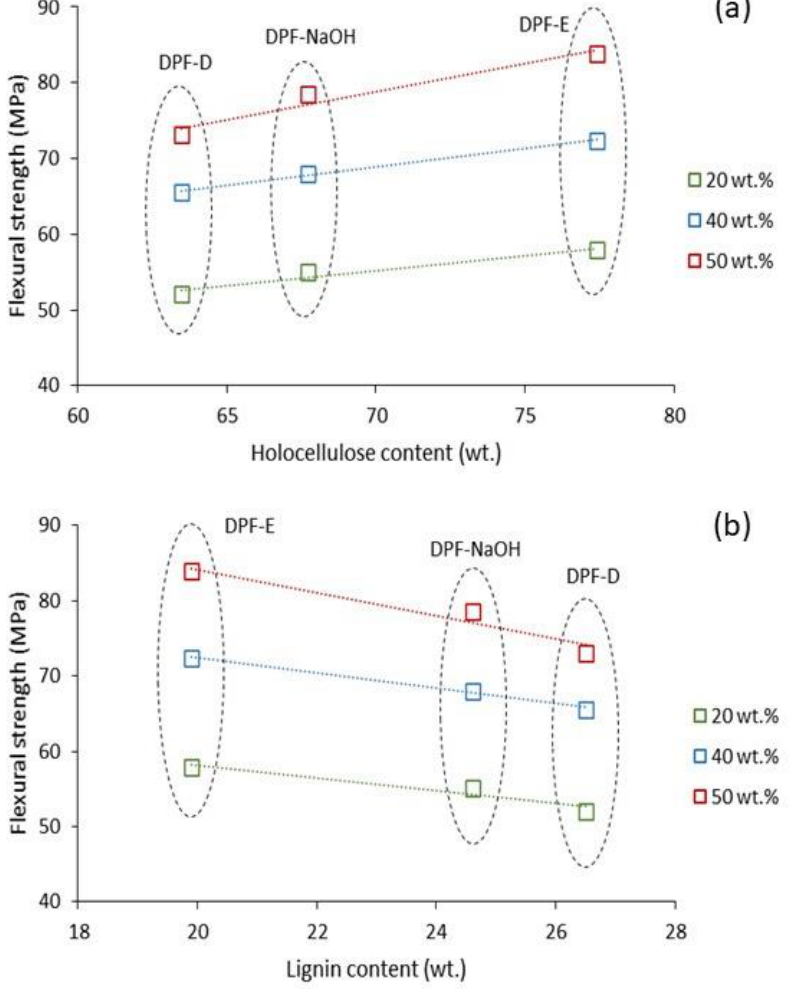
Figure 7. Evolution of the flexural strength of composites with the holocellulose ( a ) and lignin content ( b ).